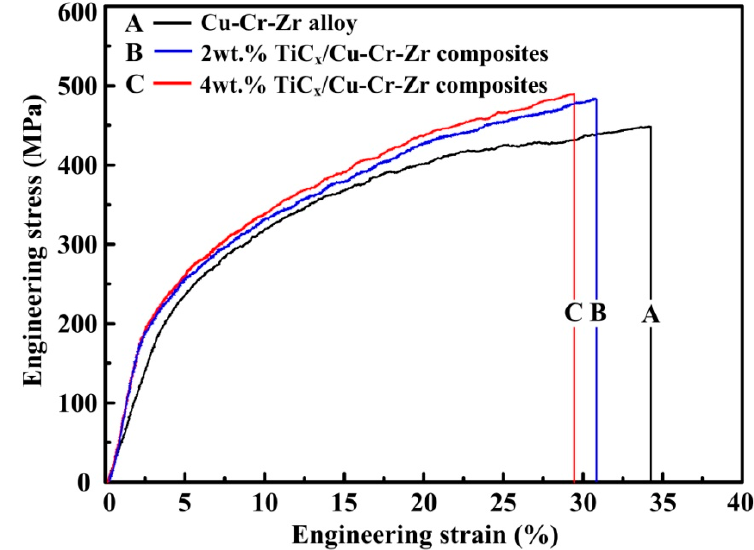
Figure 4. Engineering stress-strain curves of compressive test for ( A ) Cu–Cr–Zr alloys, ( B ) 2-wt % and ( C ) 4-wt % nano-sized TiCp-reinforced Cu–Cr–Zr composites Table 1. Compressive properties of the Cu–Cr–Zr alloys, 2-wt % and 4-wt % TiCp-reinforced Cu–Cr–Zr composites.